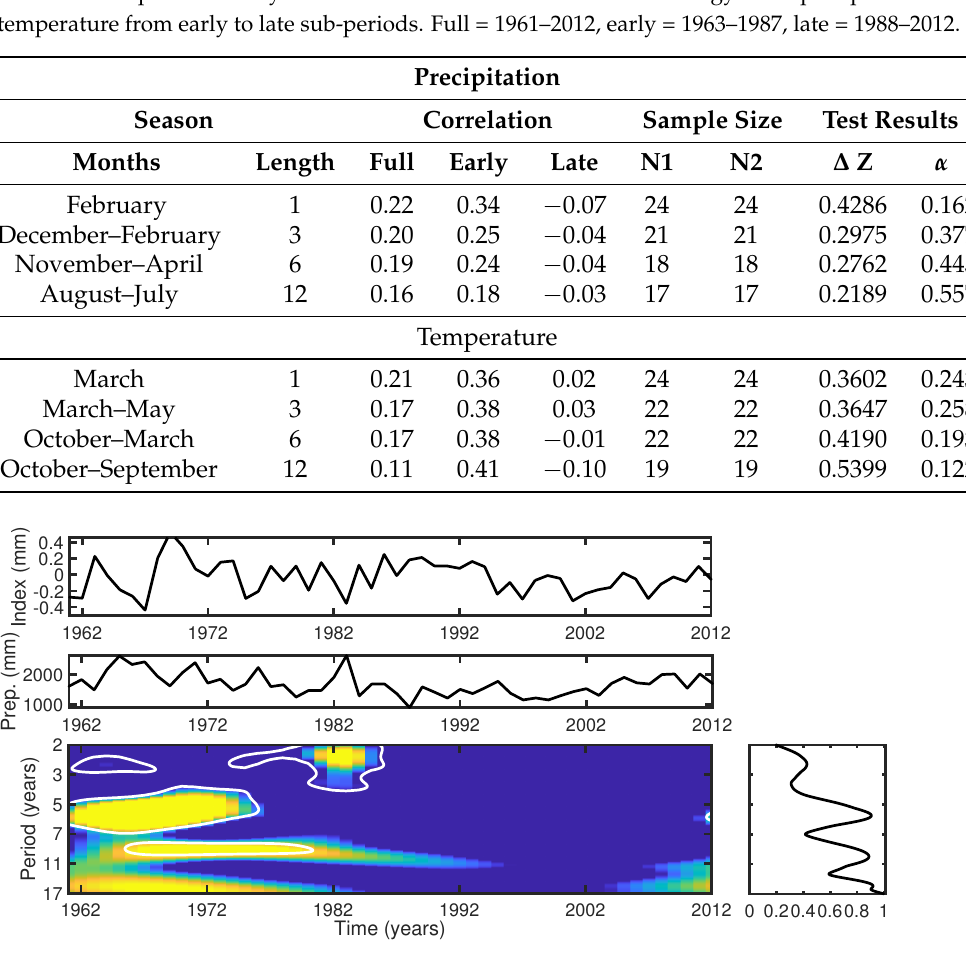
Table 3. Temporal stability of Pearson correlation of mean chronology with precipitation and